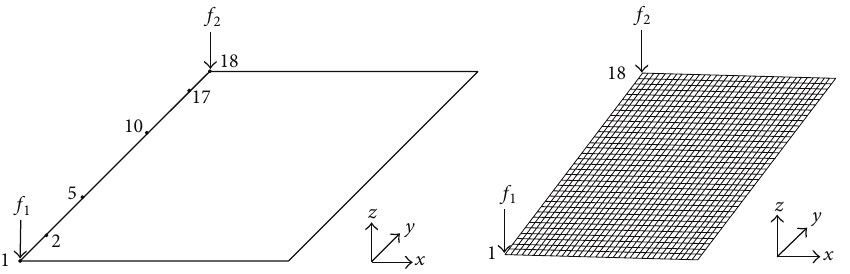
Figure 16: The location of 𝑓 1 and 𝑓 2 in the Mindlin